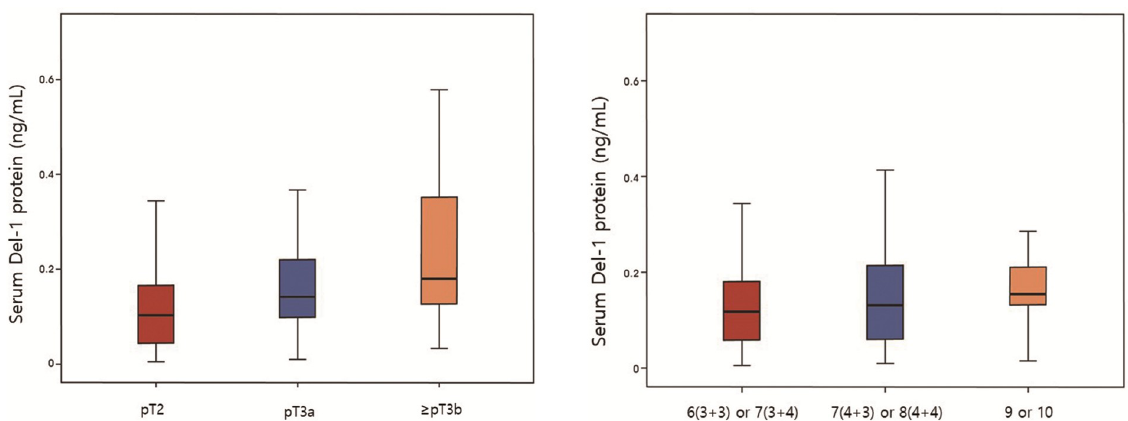
Fig 6. Developmental endothelial locus-1 protein according to (A) pT stage and (B) Gleason score in 181 patients who underwent radical prostatectomy.